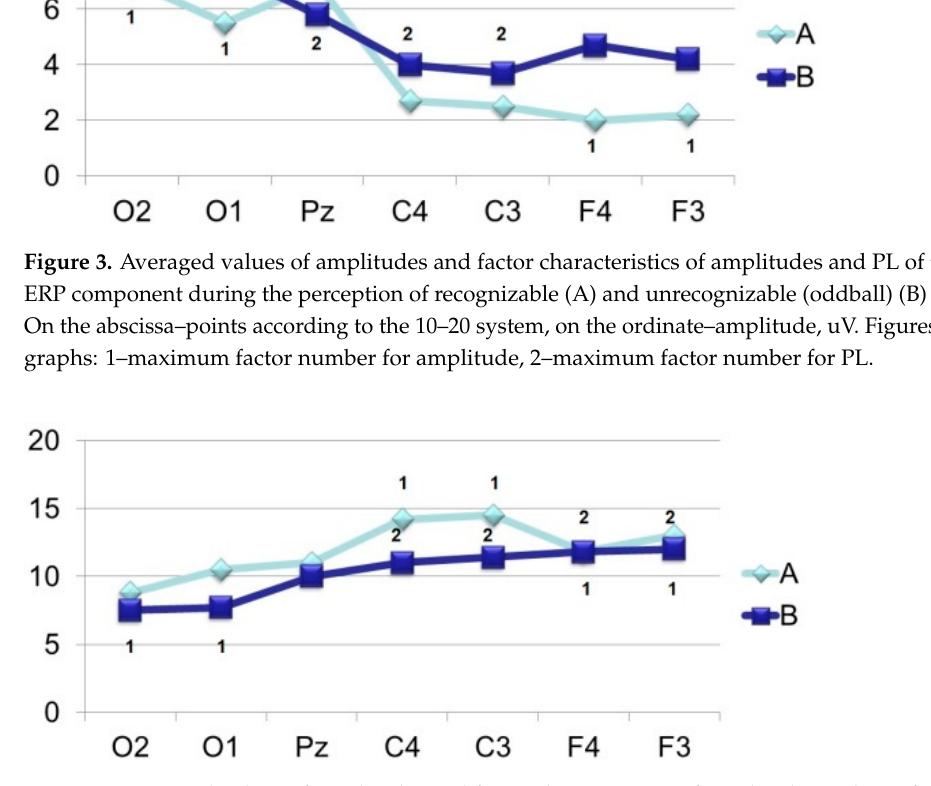
Figure 3. Averaged values of amplitudes and factor characteristics of amplitudes and PL of the N 70 ERP component during the perception of recognizable (A) and unrecognizable (oddball) (B) im- ages. On the abscissa–points according to the 10–20 system, on the ordinate–amplitude, uV. Figures on the graphs: 1–maximum factor number for amplitude, 2–maximum factor number for PL.